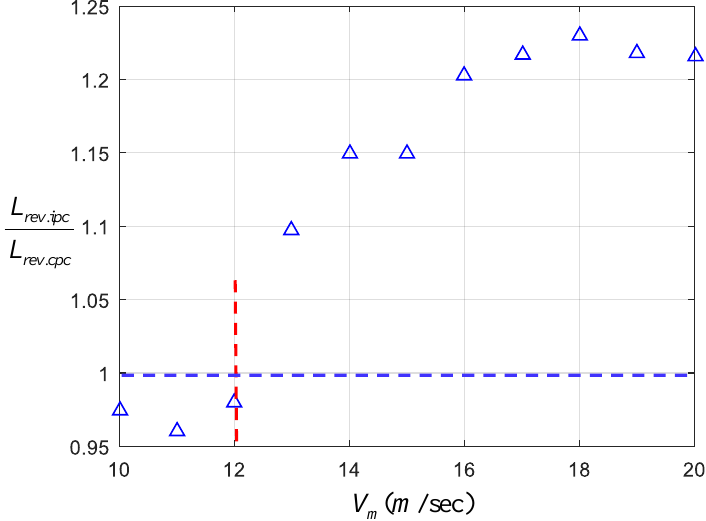
Figure 12. The ratio of life spans of bearing L rev . ipc / L rev . cpc for various wind